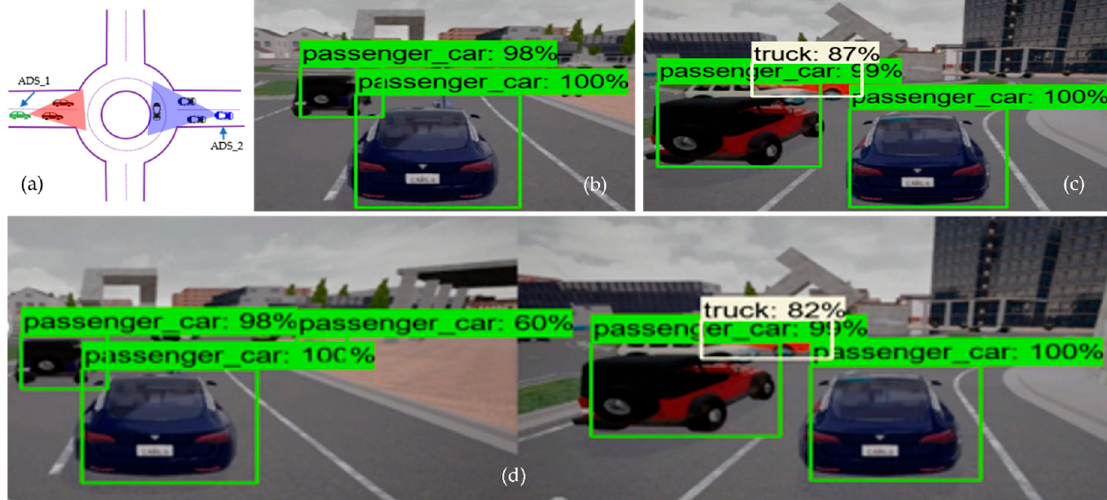
Figure 5. Top-level performance analysis of individual perception system of ADS_1 (receiver), ADS_2 (sender), and collaborative perception of ADS_1 at a roundabout driving scenario. ( a ) represents a roundabout driving scenario, ( b ) represents the perception of ADS_1, ( c ) represents the perception of ADS_2, and ( d ) represents the collaborative perception of ADS_1.